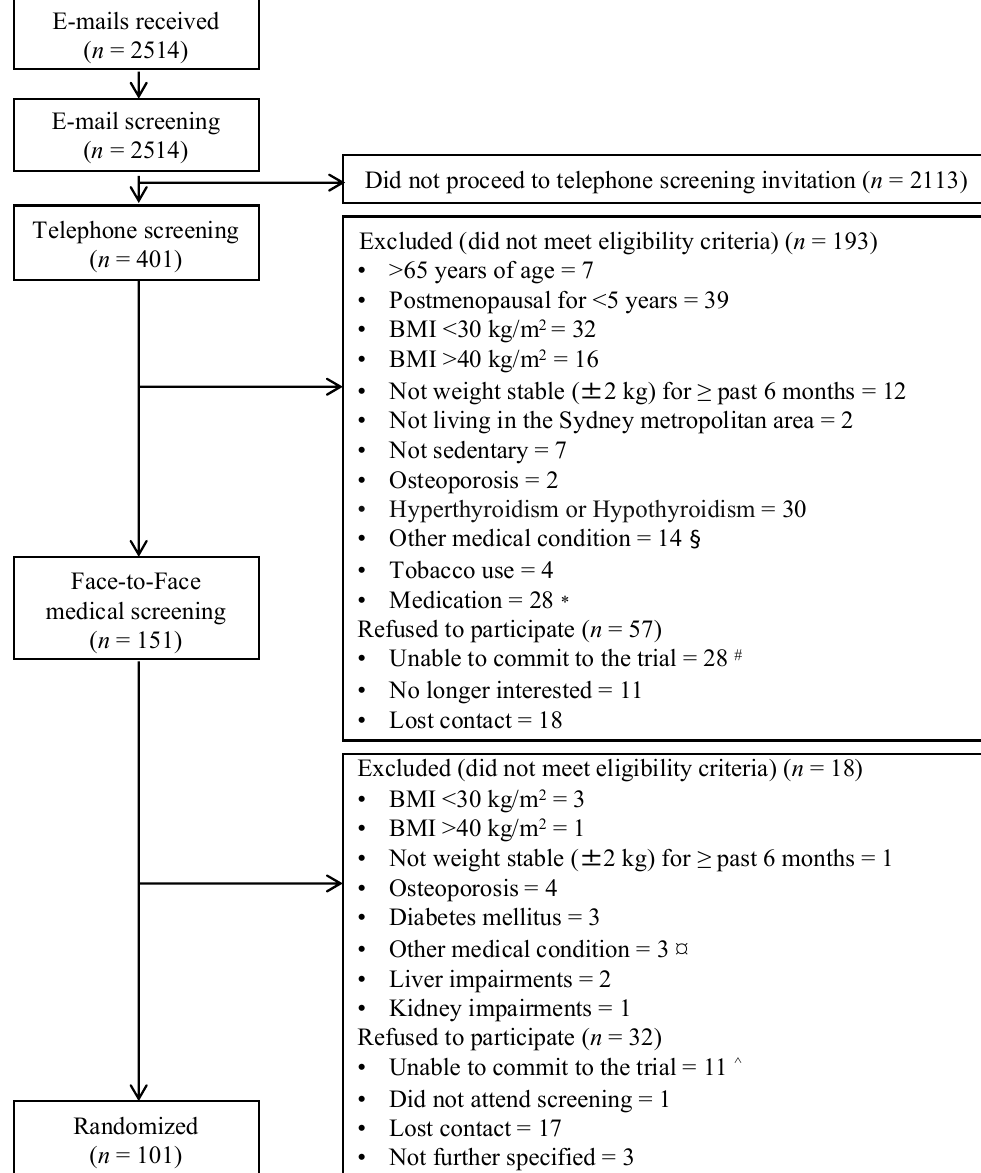
Figure 1 . Recruitment flowchart . BMI = body mass index. § History of abnormal liver function = 2, metal in body that was incompatible with magnetic resonance imaging = 5, chronic heart failure = 1, gastric banding = 6. * Anti-depressants = 21, anti-anxiety = 2, anti-epileptic = 1, anti-diabetic = 3, other medication = 1. # Time commitment = 18, not willing to undertake dietary intervention = 6, not willing to undertake trial procedures (blood tests, magnetic resonance imaging, body composition measurements) = 3, not willing to abstain from alcohol = 1. ¤ Taking anti-depressants = 2, hip replacement = 1. ^ Time commitment = 8, not willing to undertake dietary intervention = 1, not willing to undertake trial procedure (magnetic resonance imaging) = 1, commenced a diet by themselves =